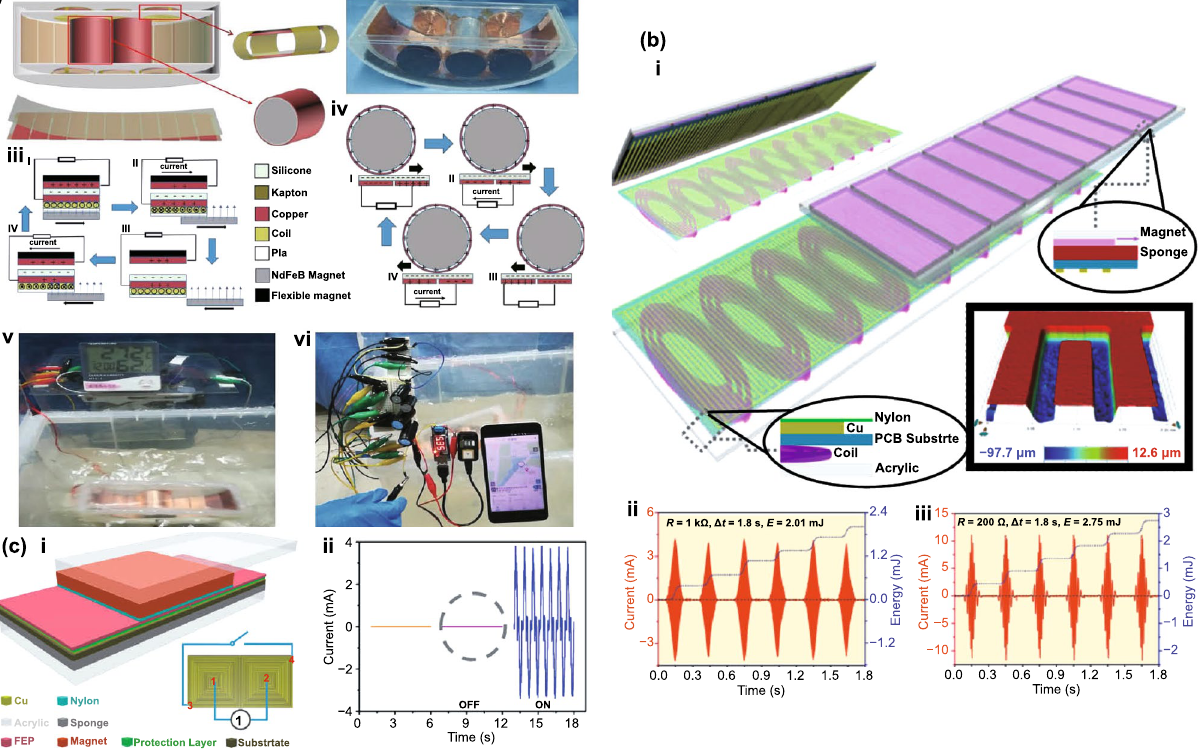
Fig. 23 a Structural design of the ship-shaped hybrid nanogenerator for blue energy harvesting developed by Wang et al. (i) Schematic diagram of the device with a free-standing TENG on the bottom and contact-separation TENGs and EMGs on both sides. (ii) Photograph of the genera- tor. Schematics diagrams of the working mechanisms of the (iii) EMG and contact-mode TENG and (iv) sliding-mode TENG. (v) Application of the generator for powering a humidity and temperature sensor. (vi) Application demonstration of the generator driving a general packet radio service. Reproduced with permission from Ref. [97]. Copyright 2018, Published by Elsevier Ltd. b (i) Structural design of the linear-grating hybridized nanogenerator developed by Zhang et al. and detail of the interdigitated ultramicroelectrode array. Output current and energy for the (ii) TENG and (iii) EMG after using transformers under an acceleration of 20 m s −2 . Adapted from Ref. [98]. c (i) Schematic diagram of the sliding shared-electrode-based hybridized generator designed by Quan et al. (ii) Measured output current signals of the hybridized nanogenerator after turning a switch. Reproduced with permission from Ref. [99]. Copyright 2016, American Chemical Society. (Color figure